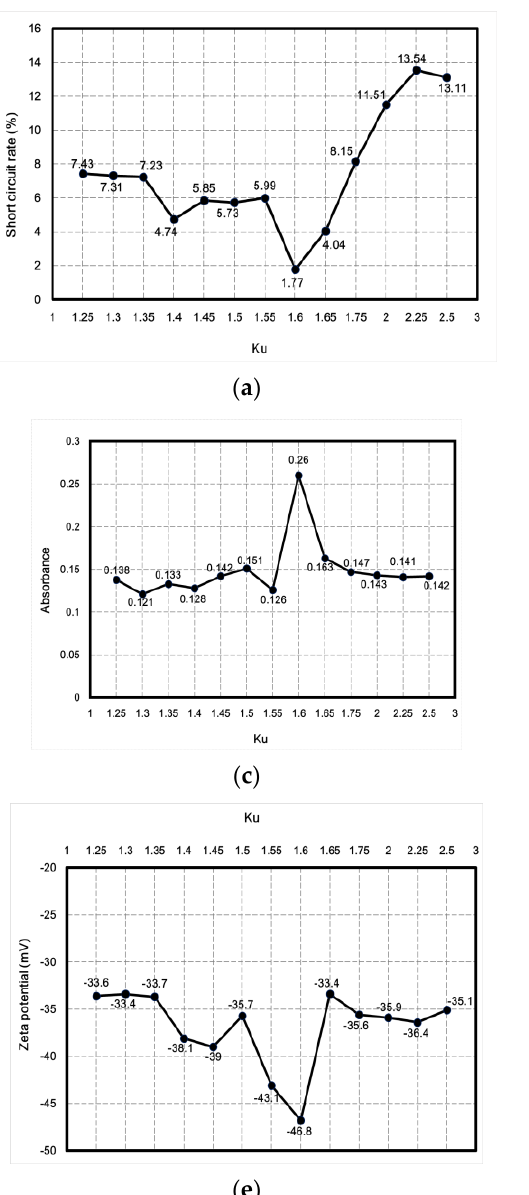
Figure 10. Curves describing the relationship between K u and nanoparticle characteristics: ( a ) short-circuit rate, ( b ) ratio between short-circuit rate and discharge success rate, ( c ) absorbance, ( d ) particle size, and ( e ) zeta potential.